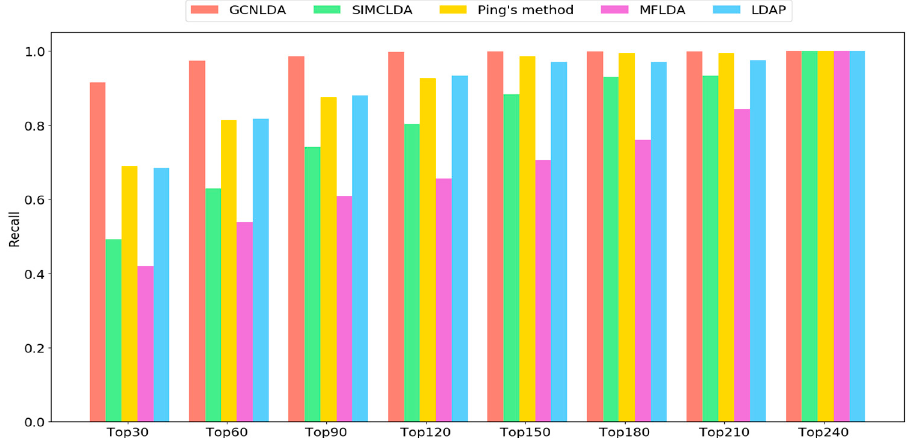
Figure 5. Average recalls across all tested diseases under different top k cutoffs.